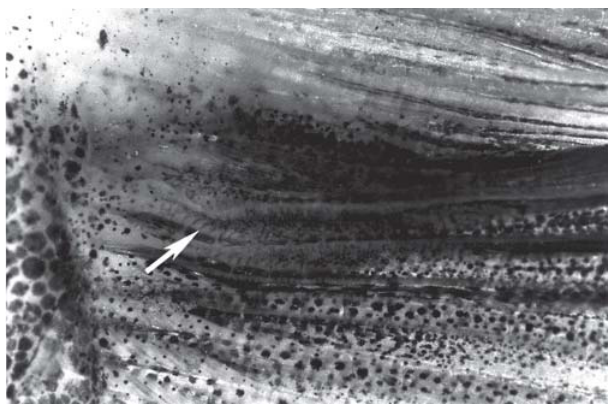
Fig. 37. Mimagoniates barberi, male, USNM 327586, 32.7 mm SL; central region of caudal-fin base and fin showing beaded tissue indicated by arrow, especially along borders of rays 11